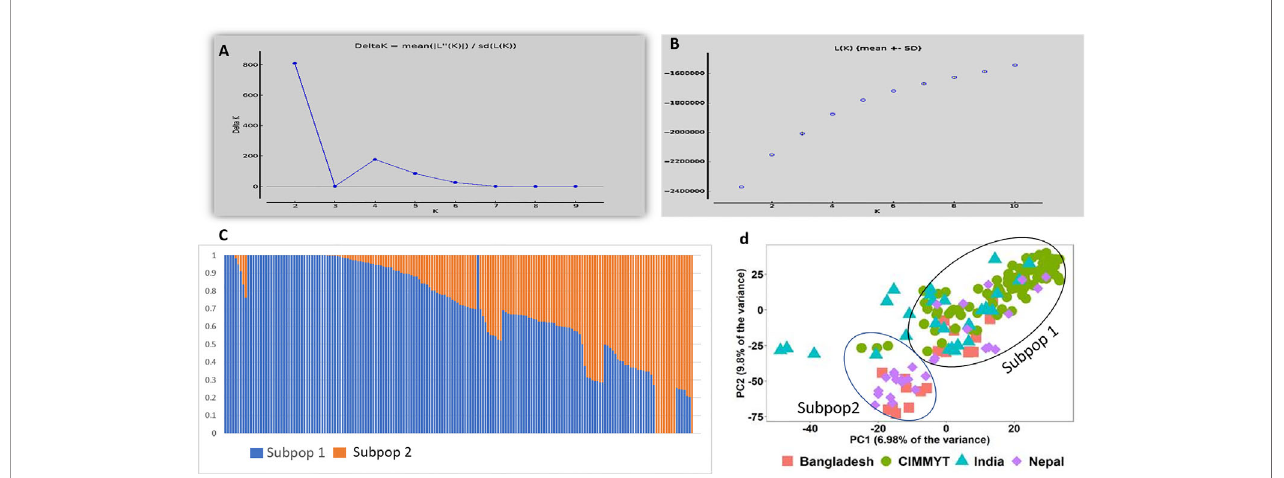
FIGURE 1 | Population structure and PCA of the 184 genotypes (A) indicating plot of D k value = 2 as compared with average k =10 (B) Log likelihood LnP(D) versus the number of K. (C) Bar plot indicating membership coef fi cient (Q value at Y axis). (D) PCA plot showing diversity in 184 wheat